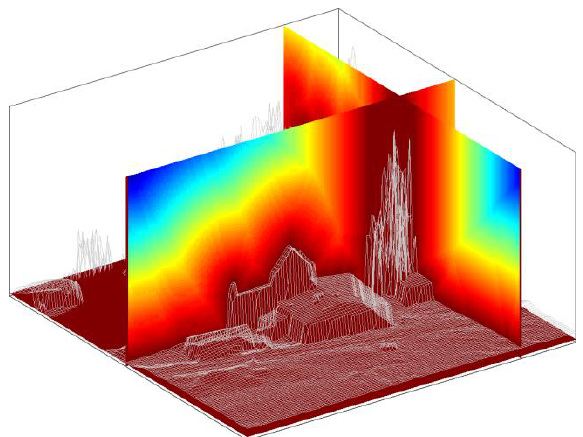
Figure 6. The three-dimensional scalar field 𝑆 holds distances to occupied space (from close to far, depicted as red to blue). It is used for obstacle avoidance during mission planning.